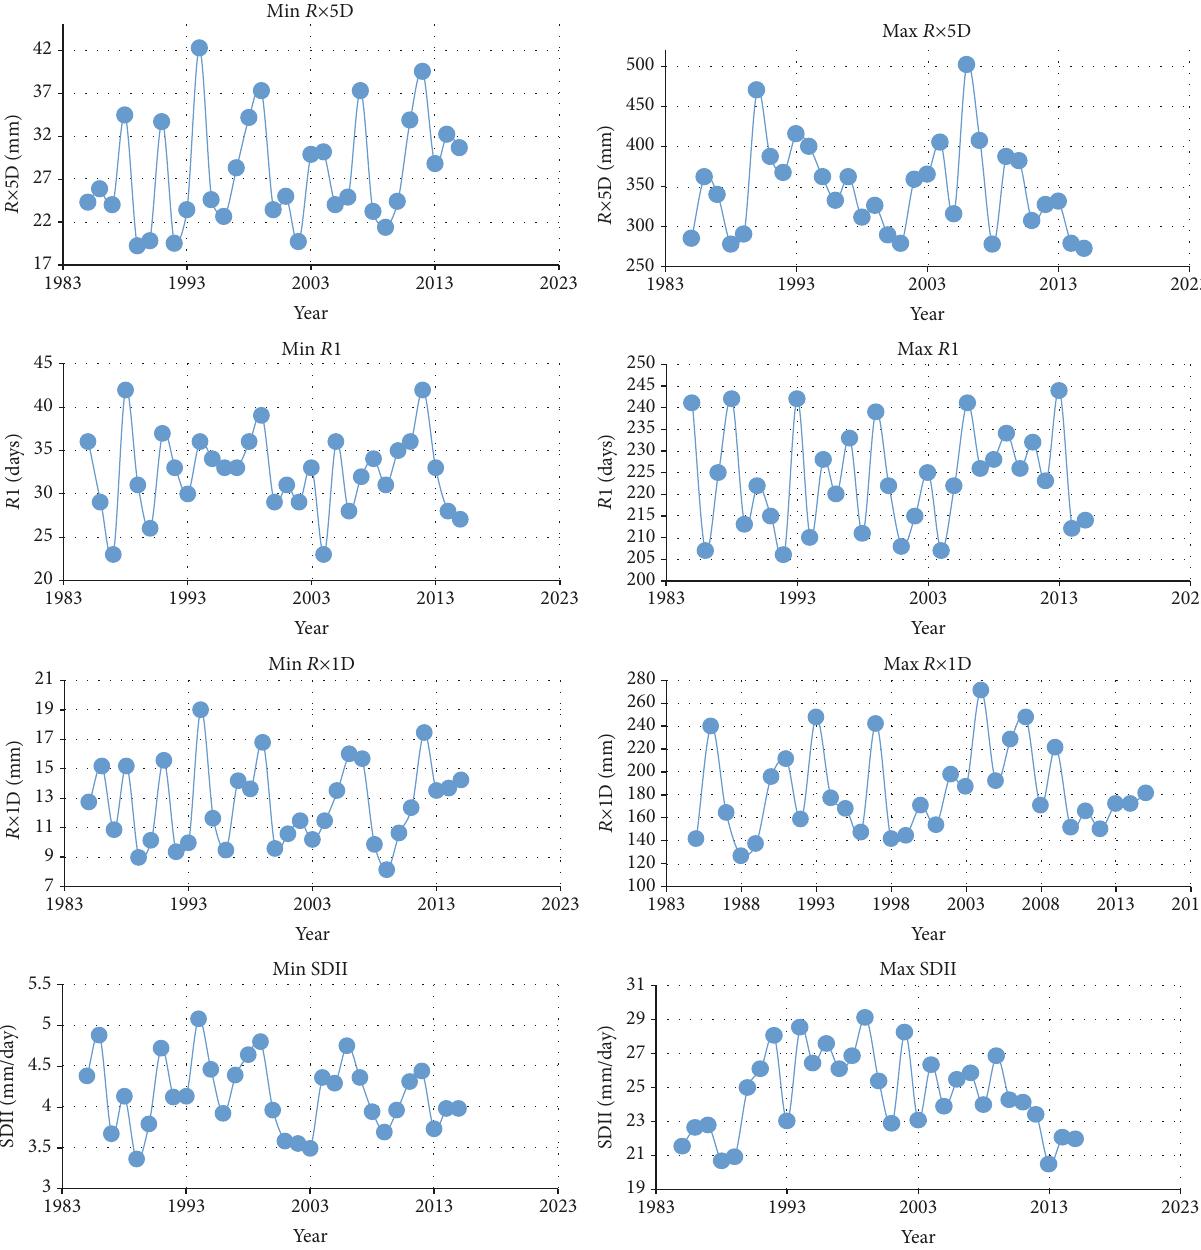
Figure 2: Temporal variation of mean index values over Nigeria from 1985 to